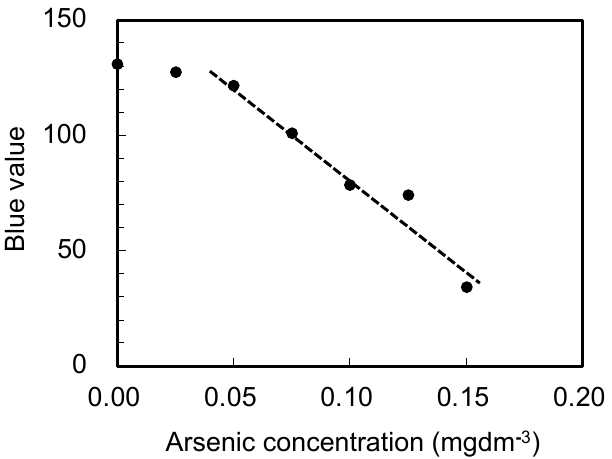
Figure 5. Change in the blue value of the image sensor as a function of the arsenic concentration in the solution.